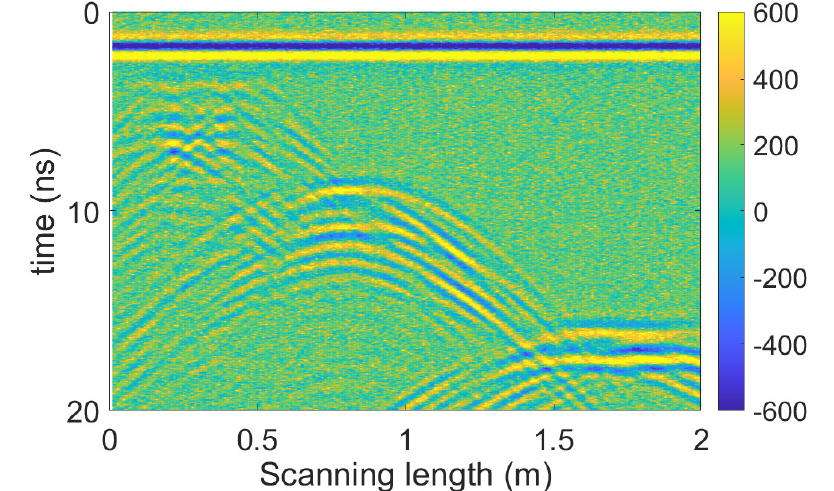
Figure 13. Polluted radargram of the model in Figure